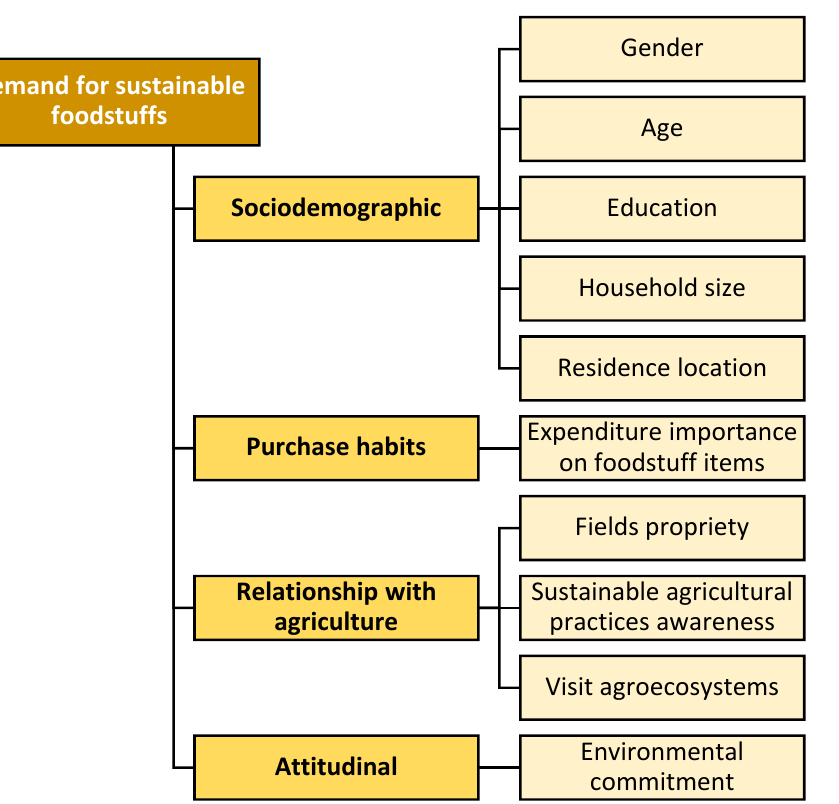
Figure 3. Drivers influencing the demand for sustainable foodstuffs.